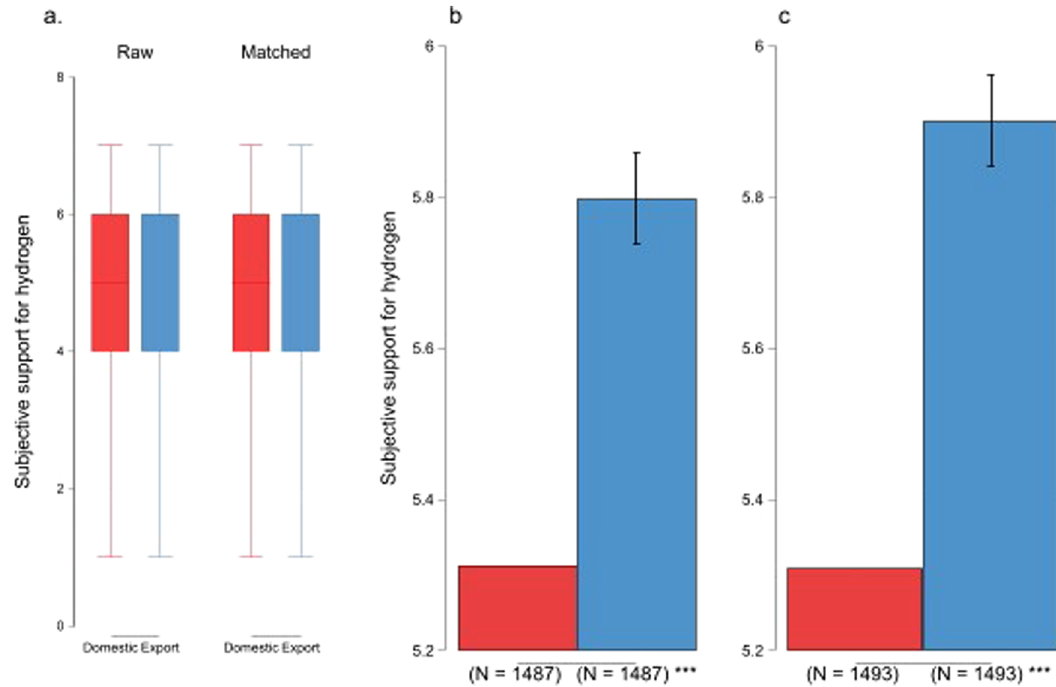
Fig. 2 Effect of information treatment on subjective support for hydrogen. Plot a shows the balance between domestic and export cohorts before the treatment. This is a diagnostic box plot to check the balance of outcome variables based on psmatch to estimate the treatment effect at baseline observational data. The average treatment effect of the cohort is 0.0242(0.0537), indicating the subjective support for hydrogen for respondents in the two streams is not signi fi cantly different. The middle and right plot shows the effect of b domestic application of hydrogen and c export consideration on subjective support before (red) and after (blue) the information treatment. Plots b and c use OLS estimates and graphs based on Bjarkefur et al.